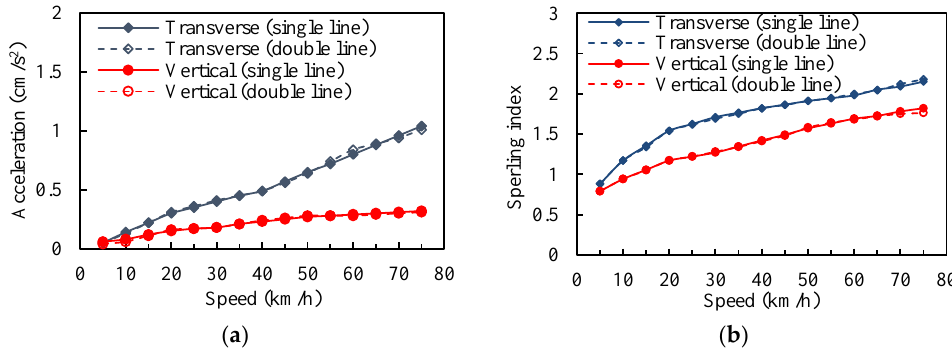
Figure 16. The responses of the monorail trains: ( a ) acceleration; ( b ) comfort index.